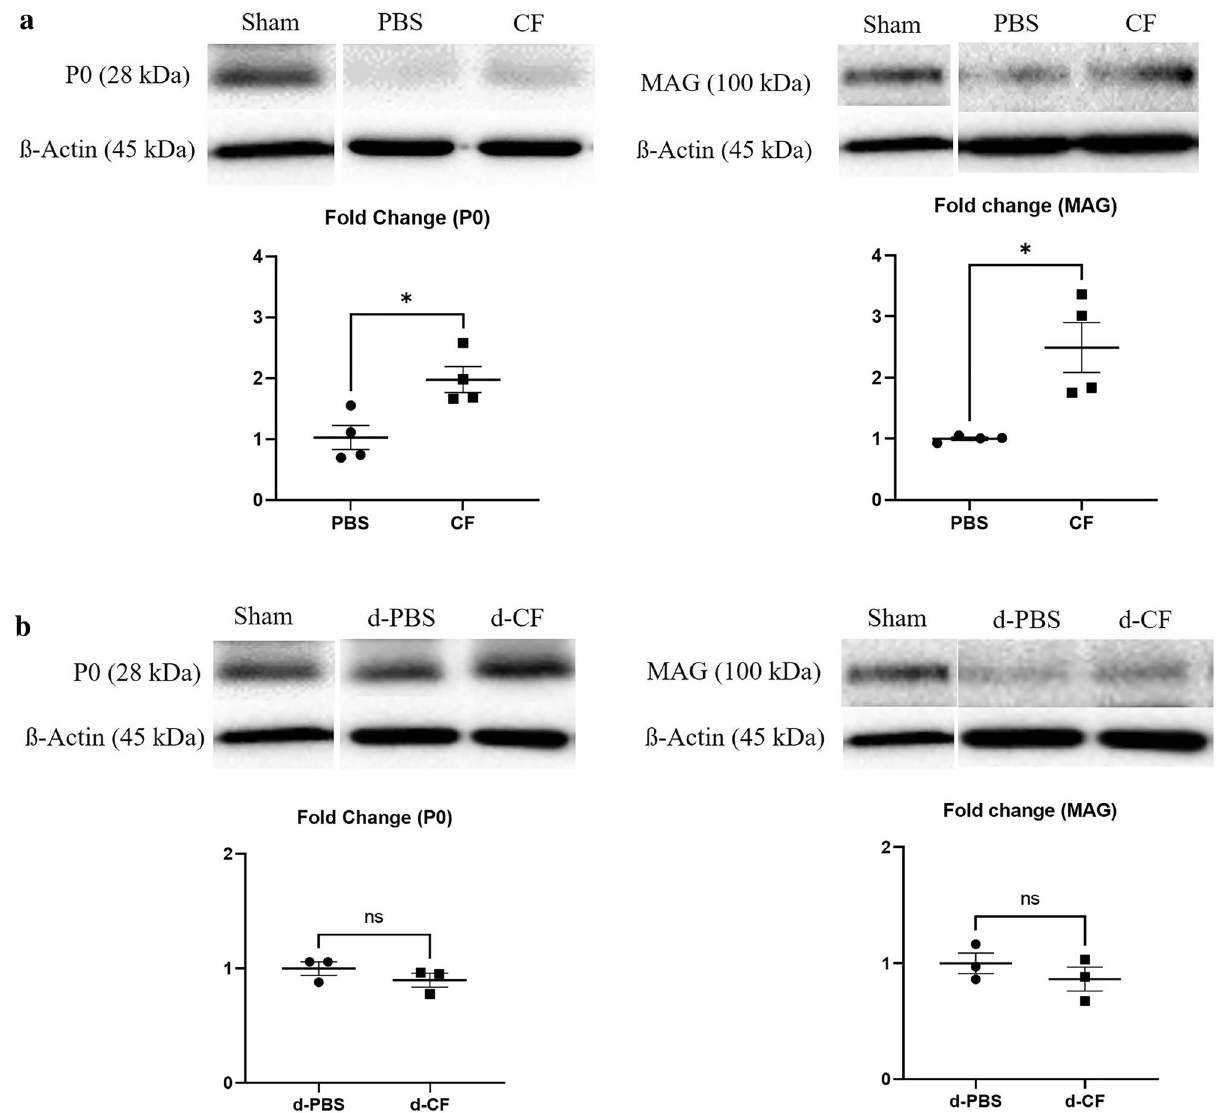
Figure 4. Representative Western immunoblotting for P0 and MAG protein in compression phase ( a ) and decompression phase ( b ) (P0, myelin protein 0; MAG, myelin associated glycoprotein; Sham, nerves of sham- operated mice; PBS, nerves of untreated mice during compression phase; CF, nerves of mice treated with clemastine during compression phase; d-PBS, nerves of untreated mice after surgical decompression; d-CF, nerves of mice treated with clemastine after surgical decompression). Full-length Western blots are presented in Supplementary Figs. 1 and 2. Band intensity quantification of P0 and MAG of CF group as fold change of PBS group. Band intensity quantification of P0 and MAG of d-CF group as fold change of d-PBS group. ß-actin was used to normalize the intensity of the bands. Error bars represent standard error of mean. Mann–Whitney U test was conducted (*p < 0.05, and n = 3 or 4 animals per